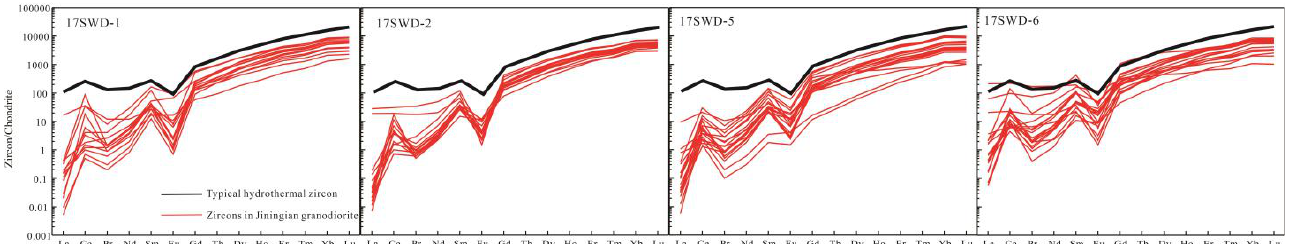
Figure 9. Zircon genetic discriminant diagrams for the Dahutang deposit (Modified after [47]). Previous data from [9]. ( a ) (Sm/La) N vs. δ Ce and ( b ) La vs. (Sm/La) N .